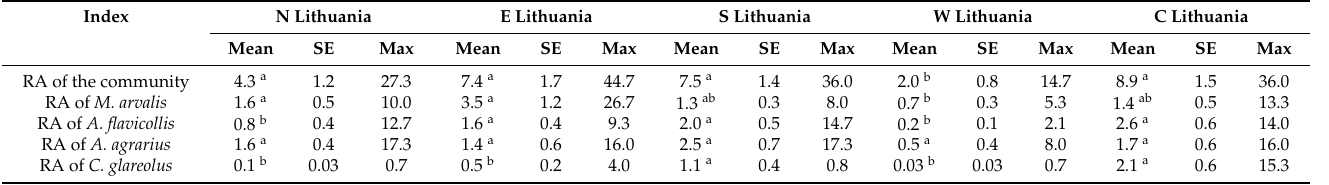
Table 3. Geographic differences of analyzed small mammal populations and species indices (RA— relative abundance, individuals per 100 trap-days; N—northern, E—eastern, S—southern, W— western, C—central part of the country), data from 2018–2020 pooled. Different superscript letters denote significant differences of averages, based on the HSD test, at p <